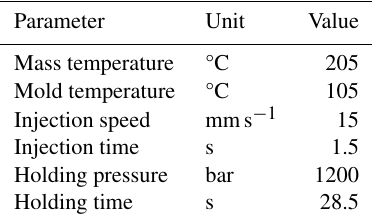
Figure 2. Coloured gear wheels: ID DG (identifier dark green, left) and ID W (identifier white, right). Table 1. Overview of processing